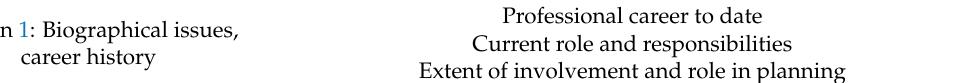
Table A5. Topic guide used as the basis for semi-structured